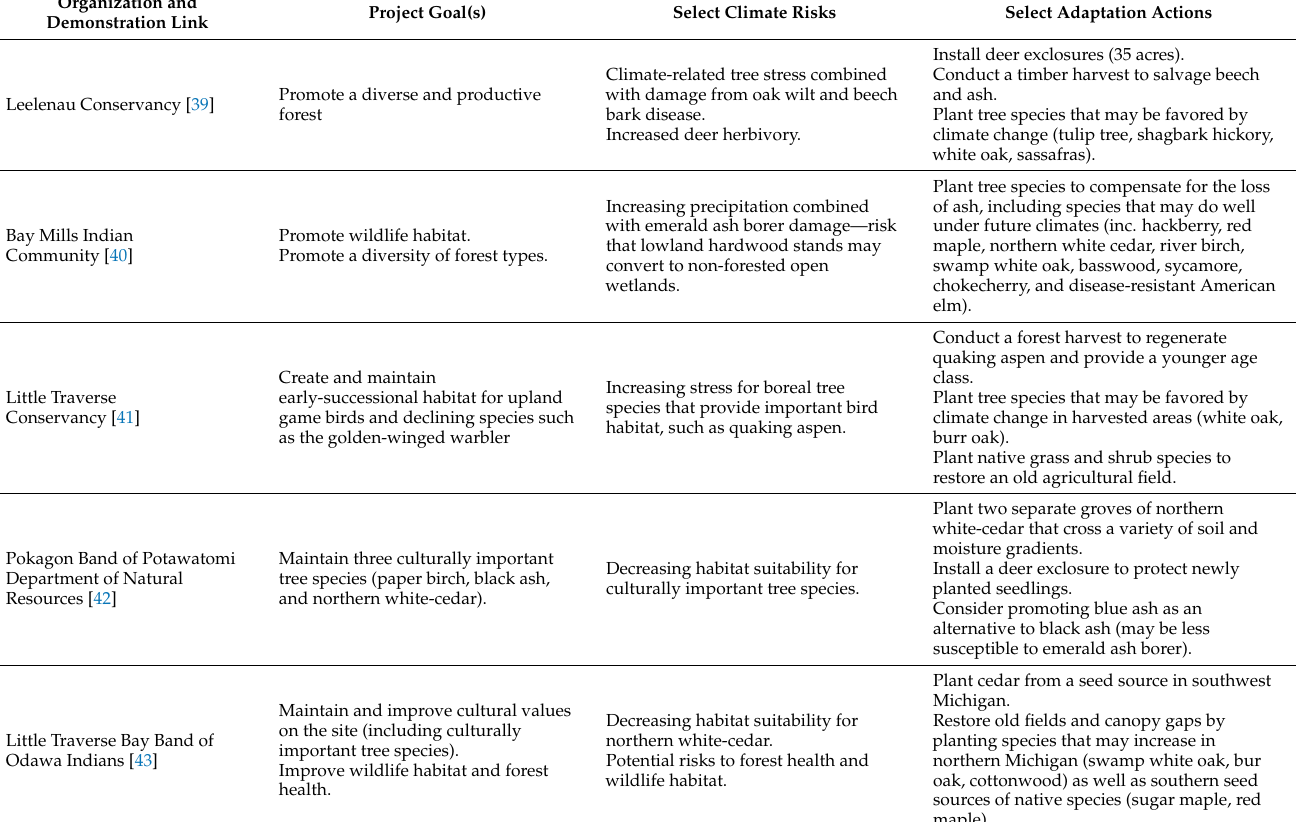
Table 3. Select summarized project goals, climate risks, and adaptation actions from five demonstration projects from the Forest Conservation and Stewardship Summit and Adaptation